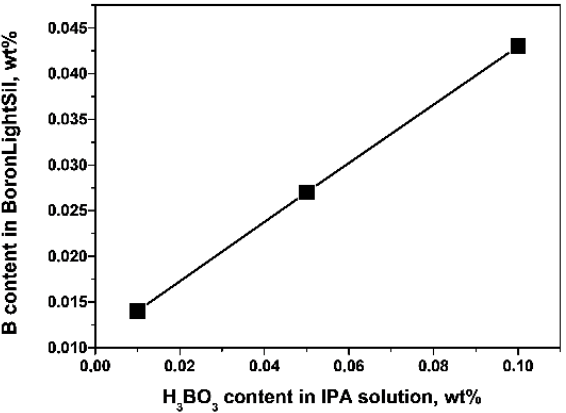
Figure 1. Boron concentration in the synthesized BoronLightSil preparations vs. H 3 BO 3 concentration in IPA solution during the gel impregnation.